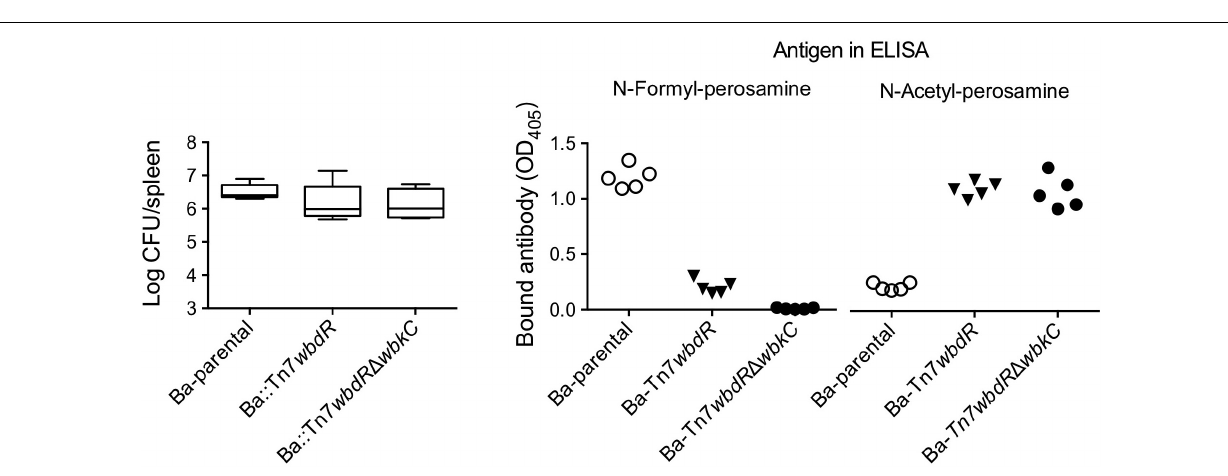
confirmed with poly- L -ornithine (not shown). Consistent